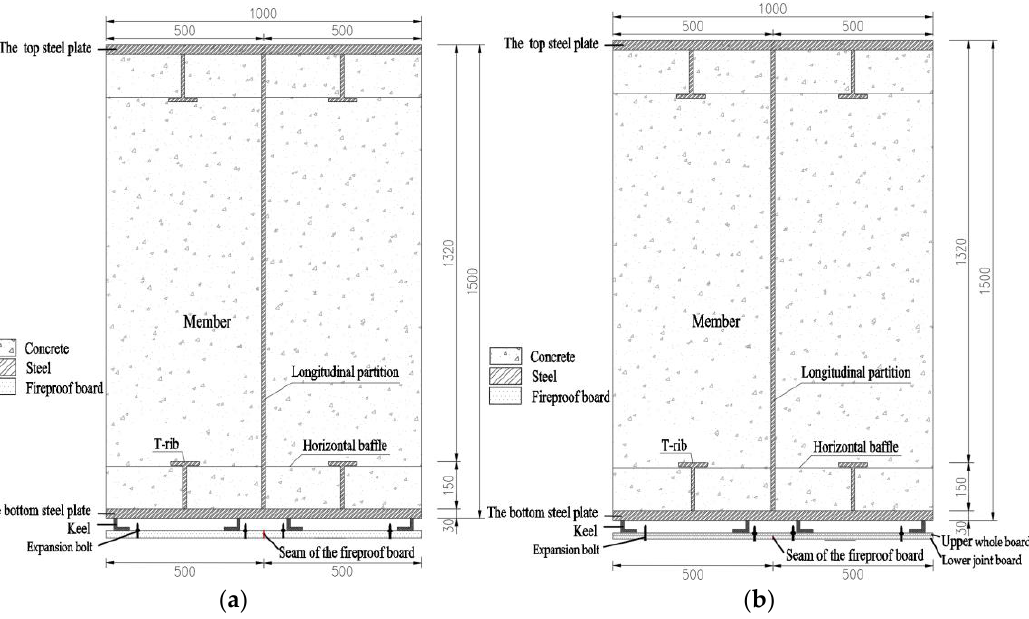
Figure 4. Working condition diagrams of the single-layer seam and the double-layer seam. ( a ) Working condition diagram of the single-layer seam; ( b ) working condition diagram of the double-layer seam.